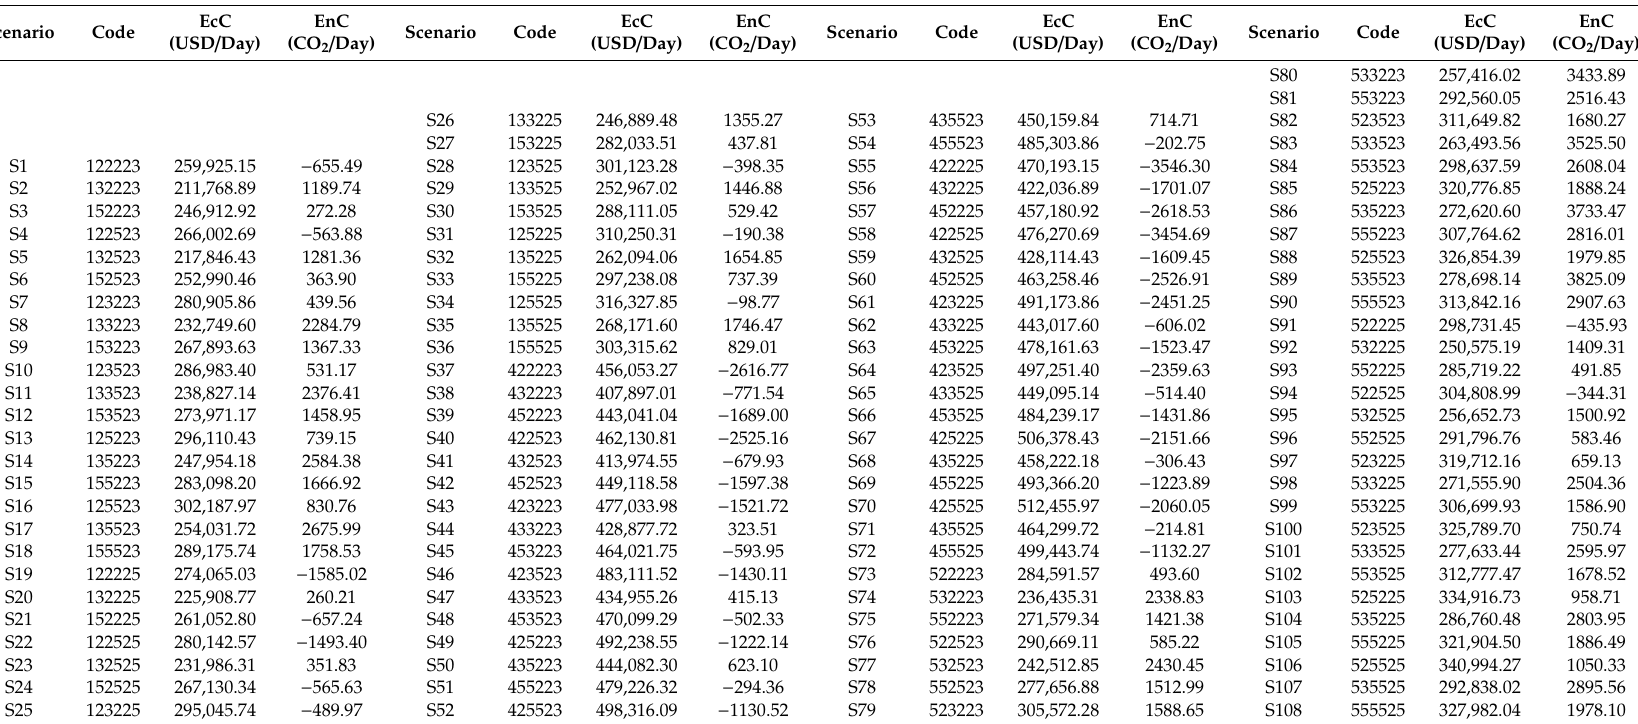
Table 6. Economic and environmental costs of comprehensive municipal solid waste treatment for all